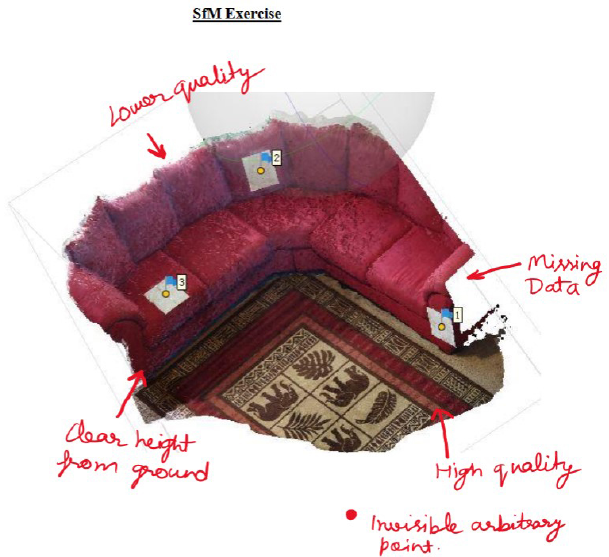
Figure 6. Student SfM product from Day 1 exercise (created by student in course; student not disclosed to comply with Institutional Review Board). Student successfully assessed relative data quality as indicated by student’s markup and where data were missing or of low